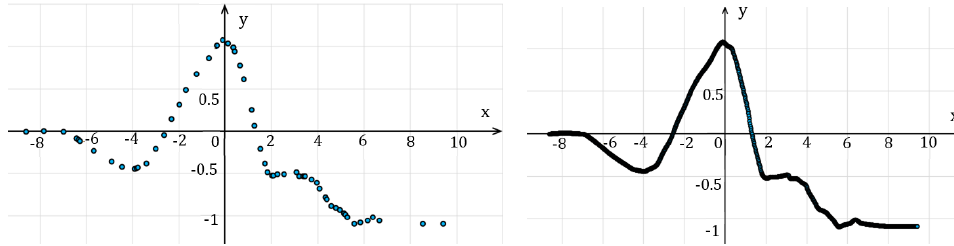
Figure 7. The points of layer A before interpolation on the right side and the points of layer A after interpolation on the